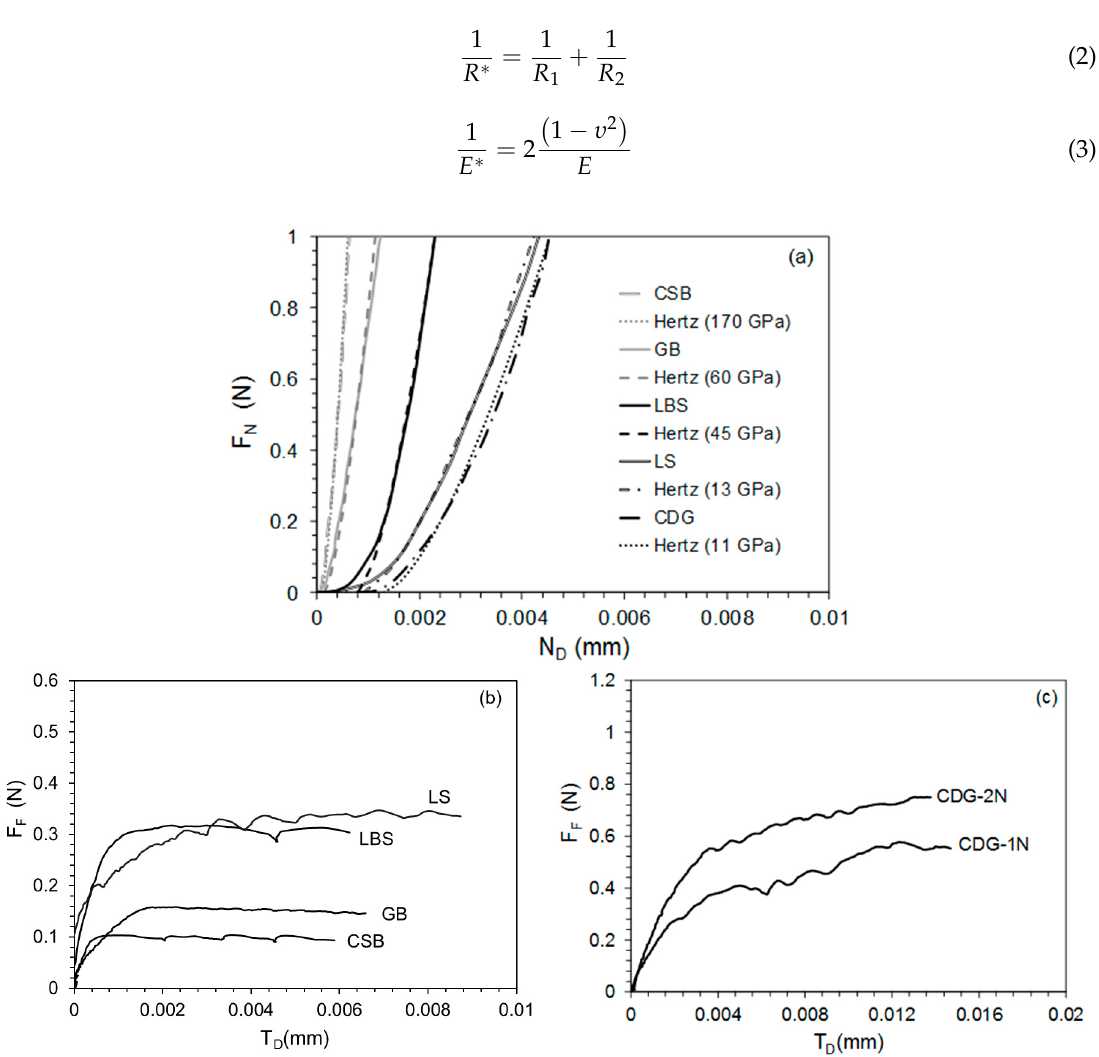
Figure 3. Representative curves showing: ( a ) normal force against normal displacement up to 1 N along with Hertzian fitting; ( b ) frictional force against displacement for materials tested at 1 N of normal force; and ( c ) frictional force against displacement for CDG at 1 and 2 N of normal force.